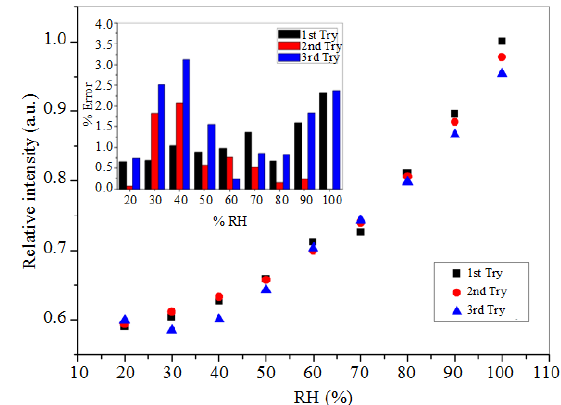
Fig. 9 Repetitive test result of the tapered fiber sensor coated with the GO/PVA composite.